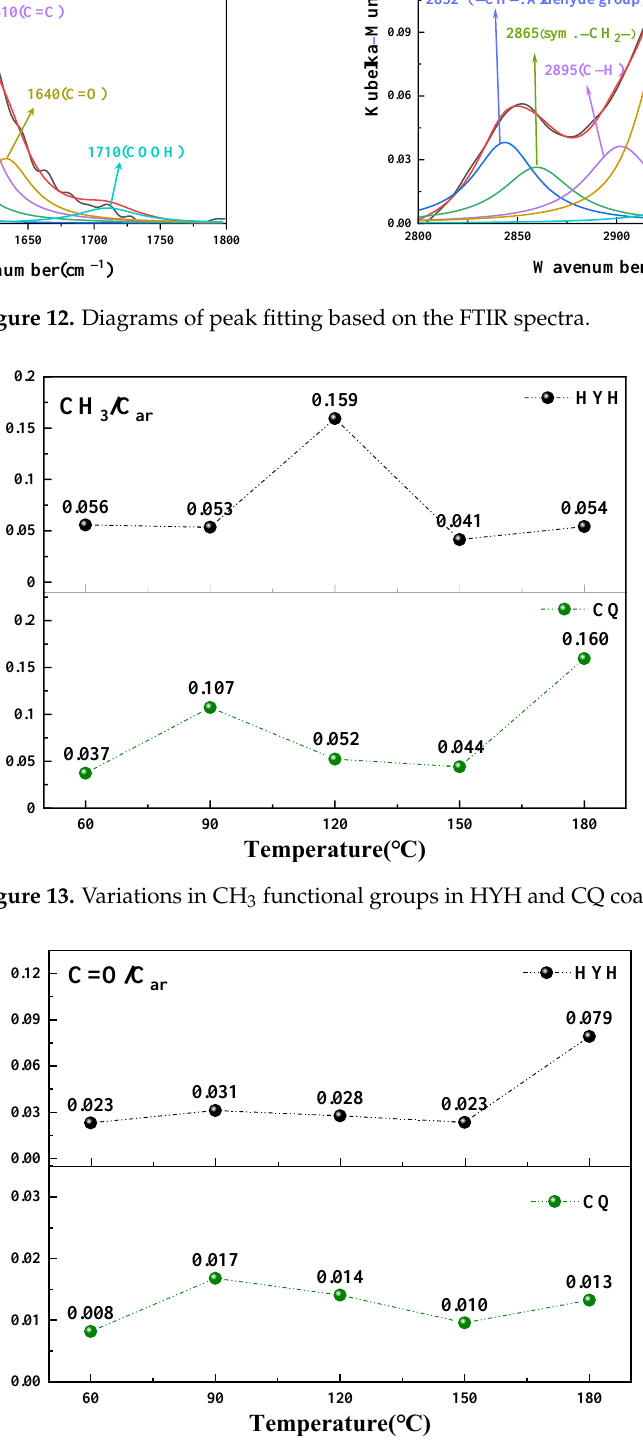
Figure 14. Variations in C=O functional groups in HYH and CQ coal samples.